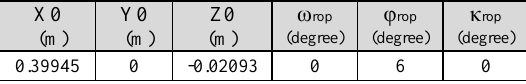
Figure 7. Comparison of relative orientation parameters errors